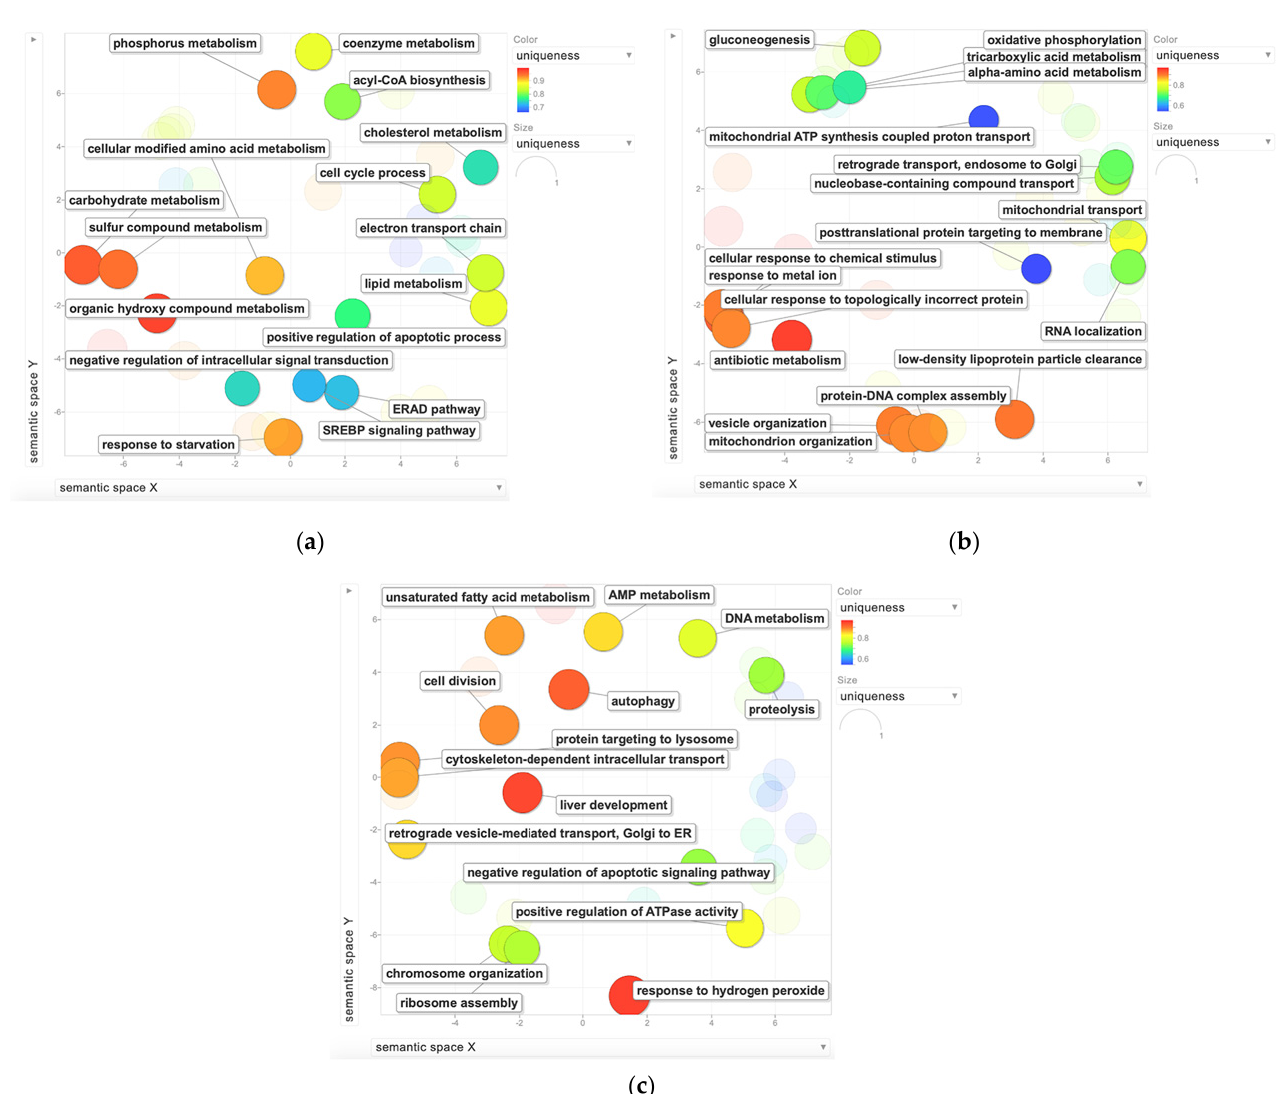
Figure 6. BPs that were specifically identified in the three treated NGB-KO conditions. Significant and non-redundant BPs were selected using REViGO software in ( a ) NGB-KO + E2 vs. Neg + E2, ( b ) NGB-KO + H 2 O 2 vs. Neg + H 2 O 2 , and ( c ) NGB-KO + E2 + H 2 O 2 vs. Neg + E2 + H 2 O 2 . The color grade of the BPs refers to the semantic uniqueness of the terms, ranging from blue (uniqueness = 0.6 or 0.7) to red (uniqueness = 1).